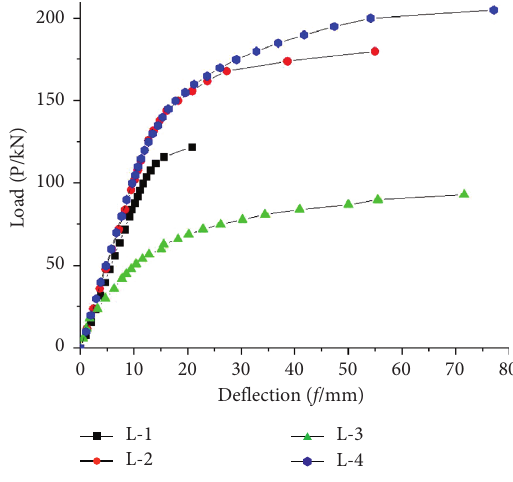
Figure 10: Load deflection curve.